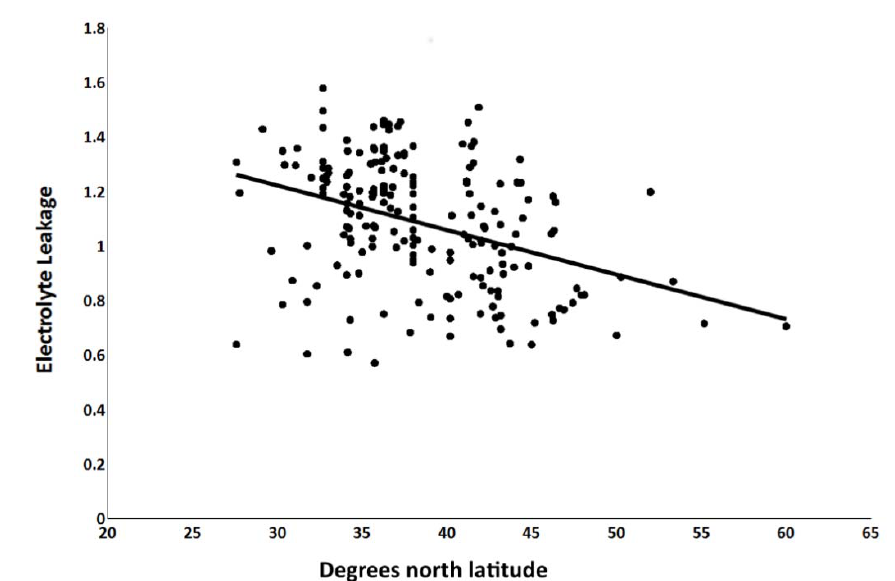
Figure 3. Regression analysis of freezing tolerance on latitude of origin of 192 winter wheat landraces. Freezing tolerance was measured as electrolyte leakage of cold ‐ acclimated seedlings following freezing to − 14, − 16, or − 18 °C. Electrolyte leakage was expressed as the arcsine ‐ transformed proportions of leakage after the freezing challenge relative to leakage after freezing in liquid nitrogen. R 2 = 0.14, p < 0.0001.